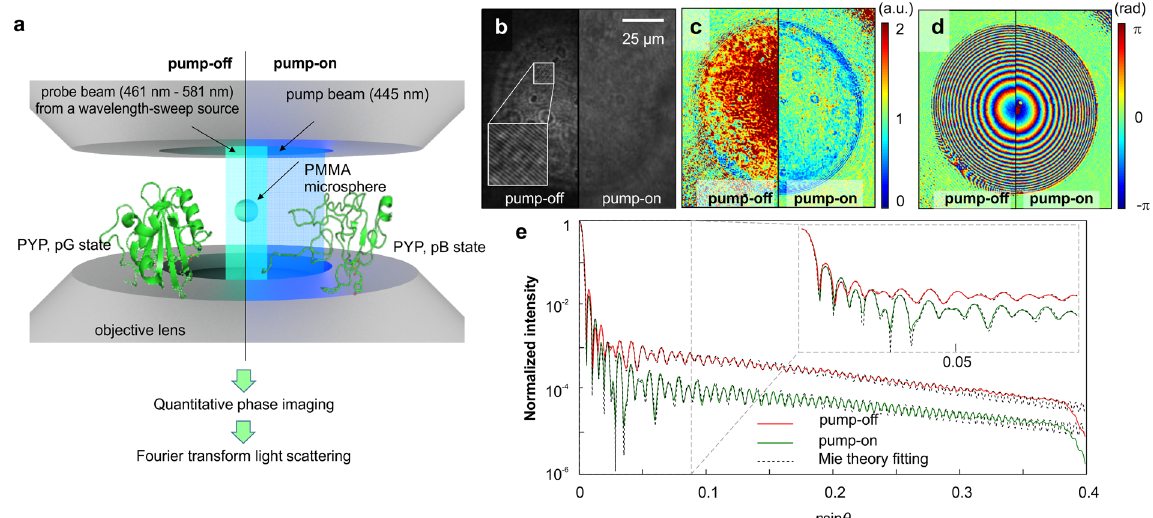
Figure 1. Experimental procedure for measuring the CRI of PYP solution. ( a ) A conceptual schematic of the measurements. The optical field of a microsphere immersed in PYP solution is obtained over a broad range of visible wavelengths; left , in the absence of a pump beam (pump-off); right , in the presence of a pump beam (pump-on), where most PYP converts to the excited state ( pB ). ( b ) Raw hologram of a PYP solution without (left) and with (right) the pump beam. ( c ) Measured amplitude and ( d ) phase images of microspheres immersed in the PYP solution. ( e ) Retrieved FTLS results of the PYP solution in pump-off (red) and pump-on (green) cases. The solid and dotted lines represent the experimental results and theoretical (Mie theory) fitting, respectively. Inset , FLTS results within the smaller scattering angle